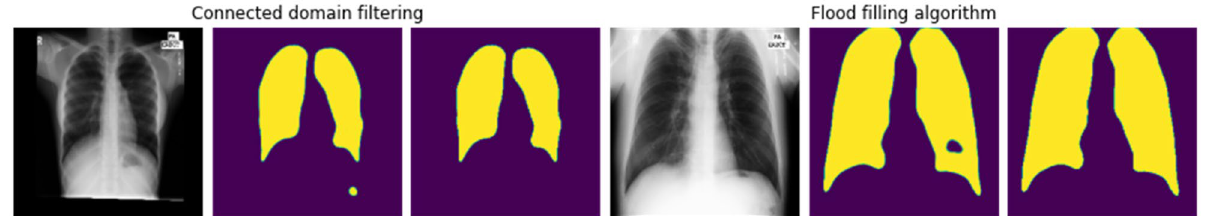
Figure 5. The connected domain filtering algorithm and flood filling algorithm.